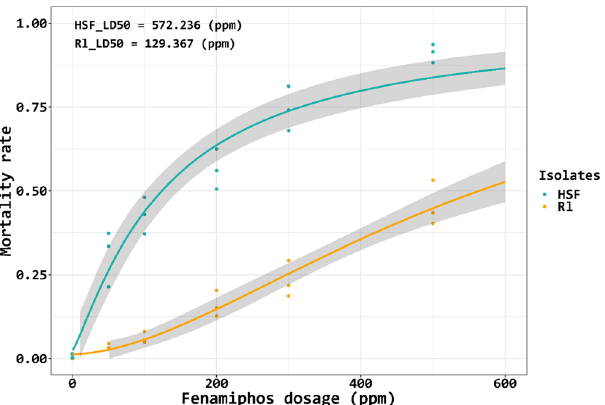
Figure 1. The fenamiphos dose–response curves in correlation to the mortality rates of the Aphelenchoides besseyi Rl and HSF isolates. Each point represents the mortality rate of population treated with corresponding fenamiphos dosage in one replicate. Grey bands indicate the degree of confidence. The median lethal doses (LD 50 ) of two isolates to fenamiphos are displayed at the top-left corner of the